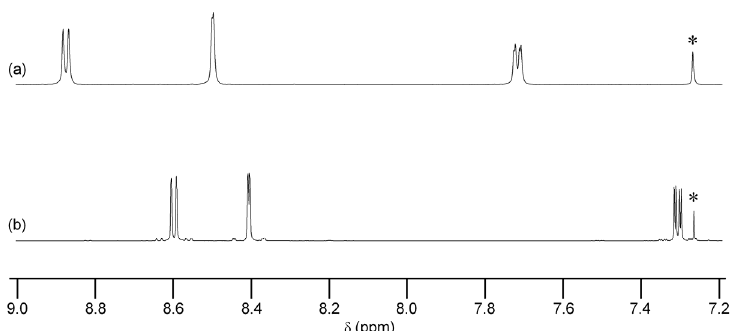
Figure 1. 1 H NMR spectra (CDCl 3 ) of ( a ) 2 and ( b ) 1 in the aromatic region ( δ 9.0–7.2). The residual solvent signal of CDCl 3 is marked with an asterisk ( ∗ ).